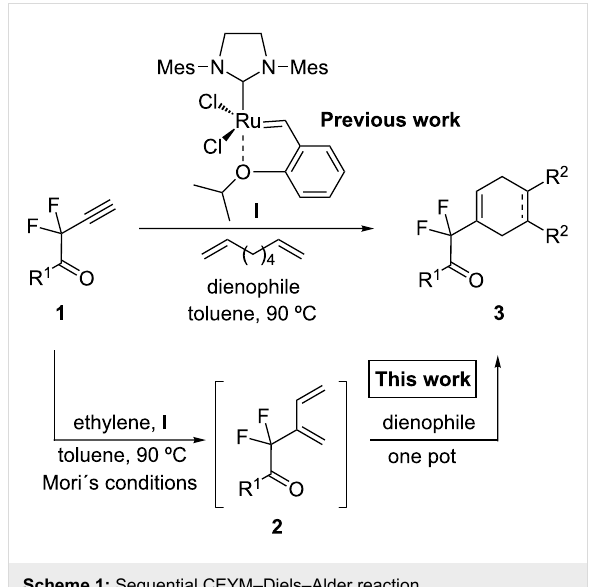
Scheme 1: Sequential CEYM–Diels–Alder